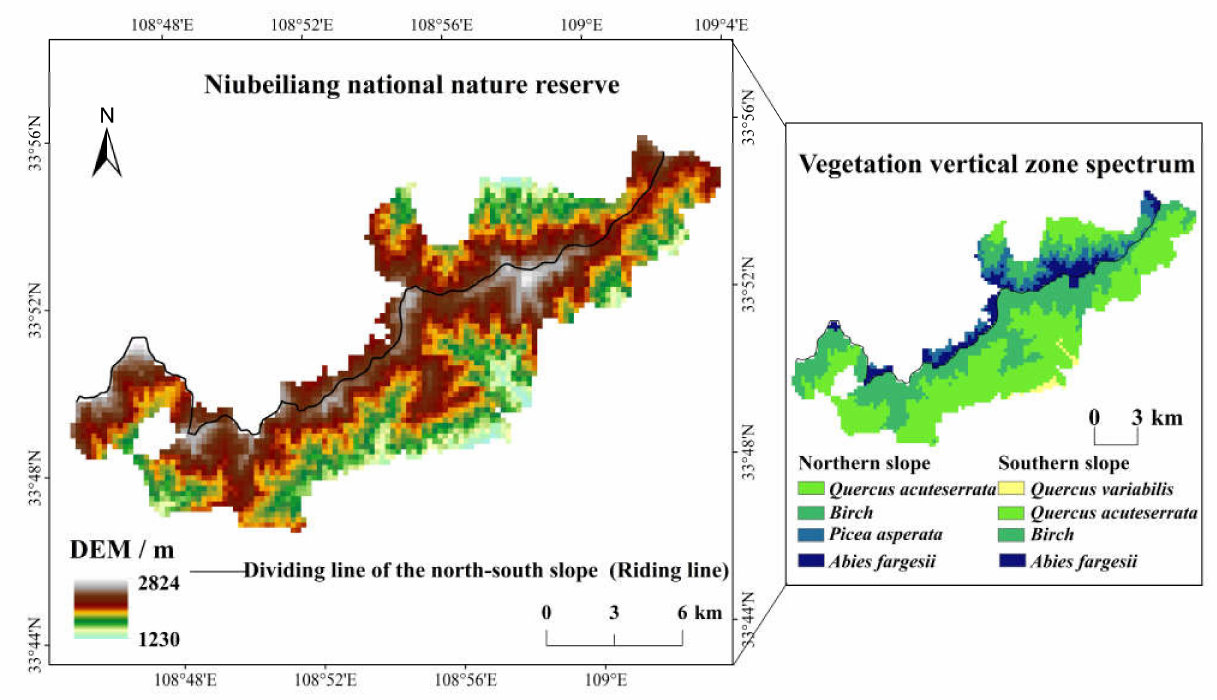
Figure 1. Geographical location of the study area and spatial distribution of its vertical vegetation